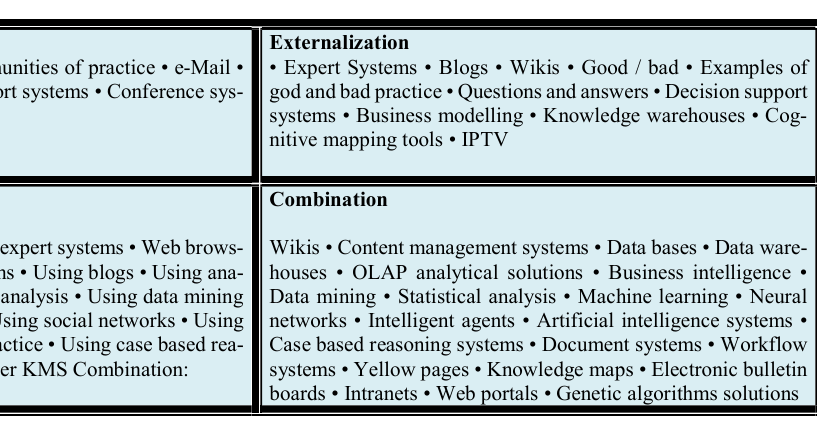
Fig. 4. Technologies that help in the process of Conversion of knowledge (Natek & Zwilling,